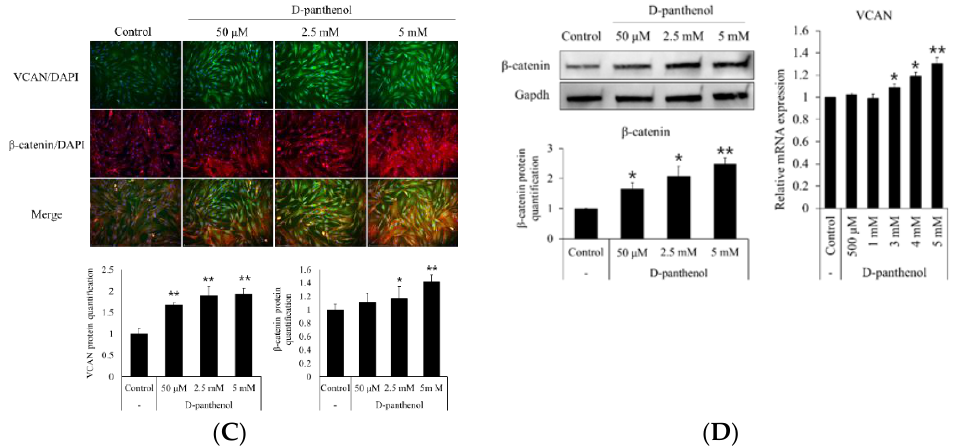
Figure 3. Anagen markers of hDPCs were significantly increased by D-panthenol treatment. ( A ) Alkaline phosphatase staining (×40 magnification) and ( B ) mRNA expression of ALP after 24 h treatment of D-panthenol in cultured hDPCs. ( C ) Versican and β -catenin expressions were double stained by immunocytochemistry after 24 h treatment of D-panthenol (×200 magnification). ( D ) Western blot analysis of β -catenin and RT-PCR analysis of versican mRNA were also performed. * p < 0.05, ** p < 0.01 versus control group. Data are expressed as mean ± SD. 3.4. D-Panthenol Reduced TGF- β1 Expression in Cultured hDPCs TGF- β1 was reported to stimulate the hair follicle to enter the catagen phase [30]. In androgenetic alopecia, precocious, repeated stimulation of the dermal papilla by andro- gens inhibits the growth of adjacent epithelial cells which leads to the progression of hor- monal baldness [31]. To evaluate whether D-panthenol possibly inhibits the catagen entry of the dermal papilla, the effects of D-panthenol on the mRNA and protein expression levels of TGF- β1 were assessed. As shown in Figure 4A, 5 mM D-panthenol significantly decreased the mRNA expression of TGF- β1 in cultured hDPCs by 30% compared to the control. Immunocytochemistry results showed that D-panthenol also decreased the TGF- β1 protein level in a concentration-dependent manner (Figure 4B).